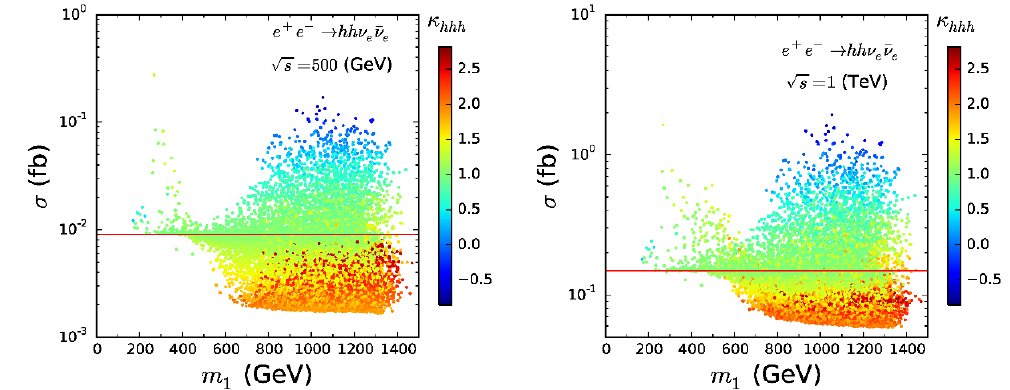
p 0 mass m 1 at s = 500 GeV 1